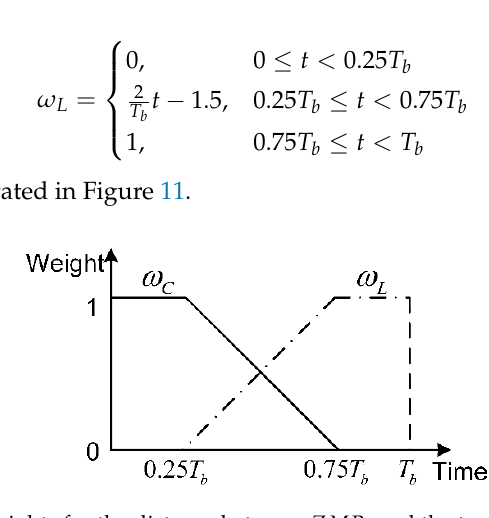
Figure 11. Weights for the distance between 𝑍𝑀𝑃 0 and the two support lines.